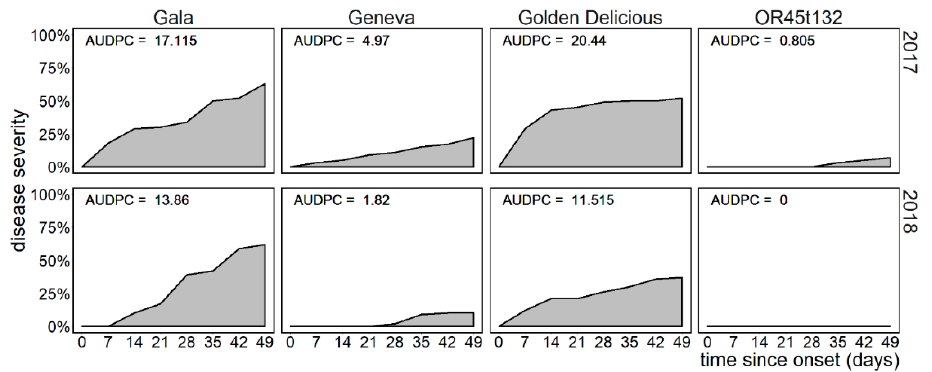
Figure 1. Progression of apple scab on four indicator cultivars in 2017 and 2018 with the area under disease progression curve (AUDPC) calculated; disease severity is defined by the proportion of infected leaves; symptoms began on 19 May 2017 and 11 May 2018.